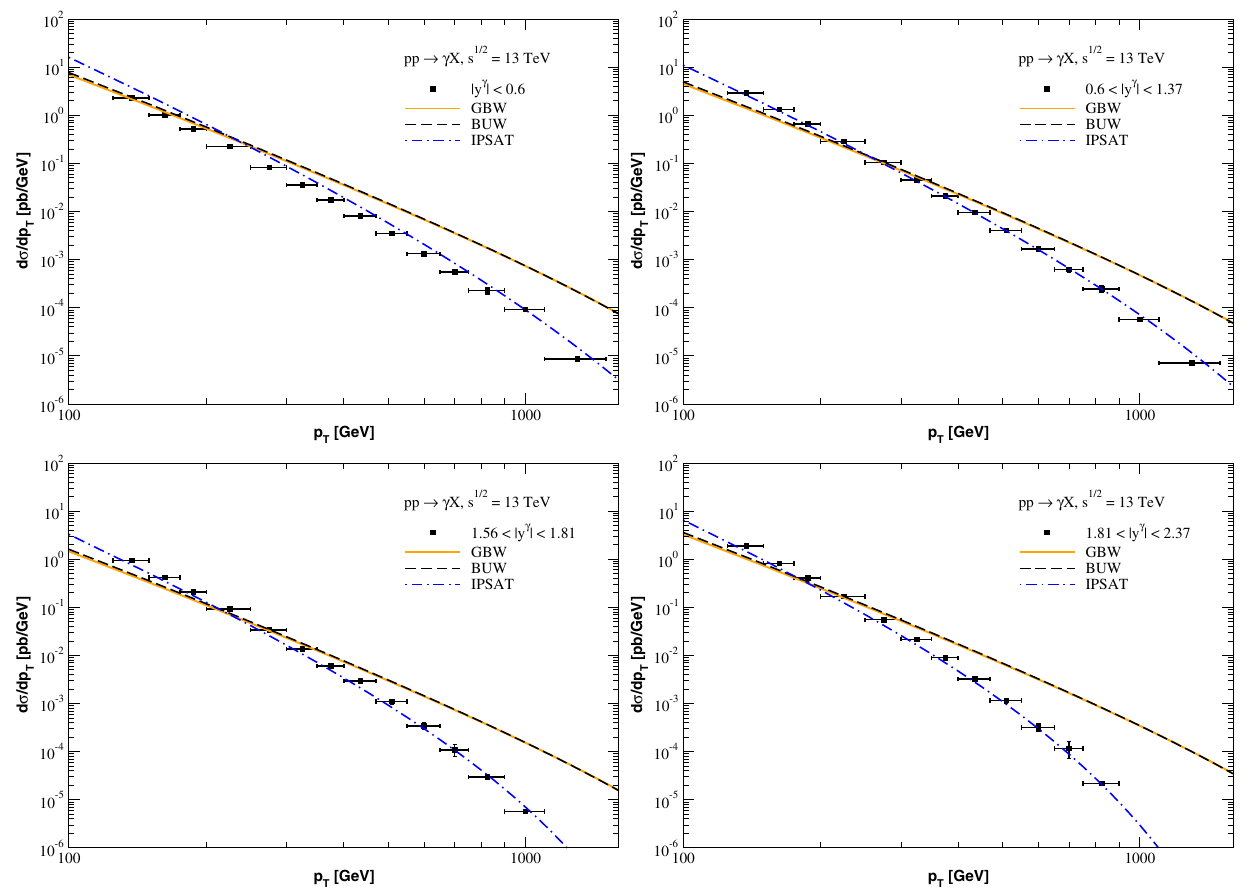
√ s = 13 TeV and considering four rapidity bins. The predictions